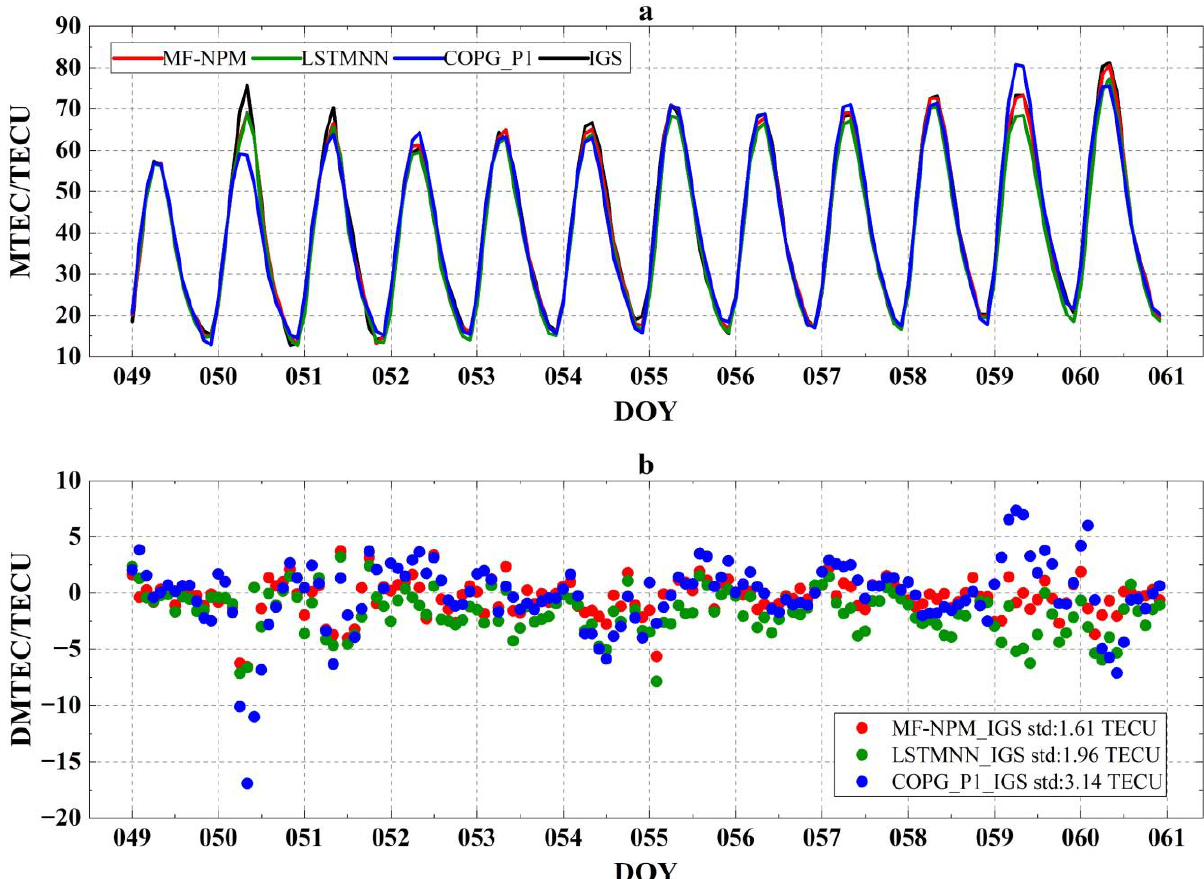
Figure 7. The variations of ( a ) MTEC and ( b ) DMTEC relative to IGS during geomagnetic storms period.